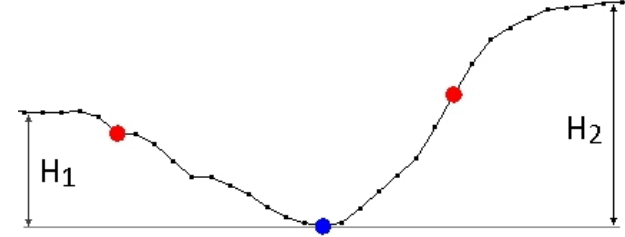
Figure 26. Determination of the maximum possible water depth.